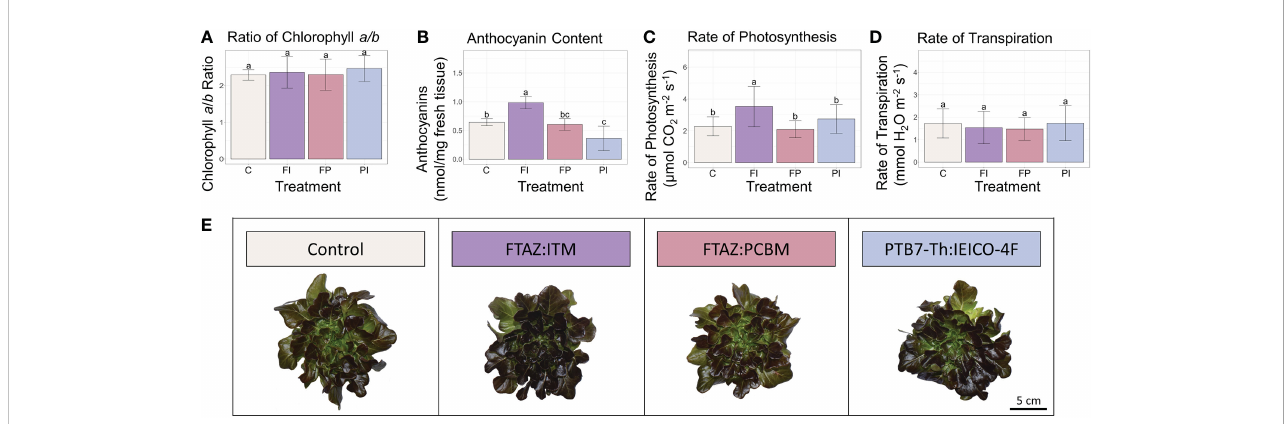
FIGURE 3 Lettuce secondary metabolites and carbon assimilation under OSC fi lters. (A) Ratio of chlorophyll a to chlorophyll b in lettuce leaf tissue. (B) Anthocyanin concentration in lettuce leaf tissue. (C) Rate of photosynthesis ( m mol CO 2 m -2 s -1 ) measured under each light condition. (D) Transpiration rate (mmol H 2 O m -2 s -1 ) measured under each light condition. (E) Representative photos of lettuce plants from each treatment. Error bars represent the standard deviation. Statistical signi fi cance was assessed by ANOVA and Tukey test (p<0.05). For each plot, the differences between the means of treatments marked with the same letter are not statistically signi fi